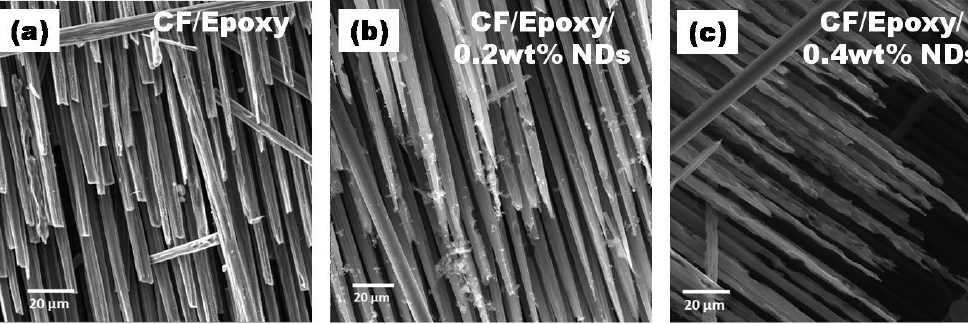
Figure 13. SEM images of CFRE-Cs: ( a ) blunt edges of fiber in CFRE-Cs, ( b ) sharp edges of fibers in 0.2 wt% NDs/CFRE-Cs, and ( c ) surface pitting on fibers in 0.4 wt% NDs/CFRE-Cs.